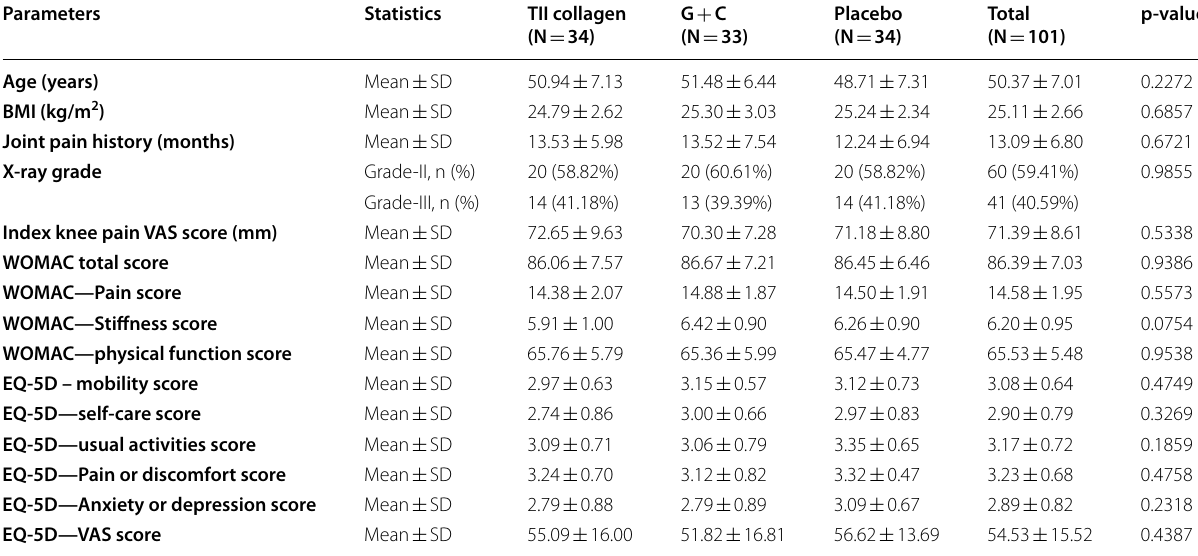
Table 3 Demographic and baseline characteristics